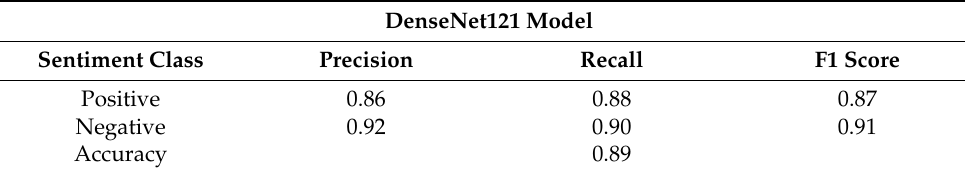
Table 6. Performance metrics of the DenseNet121 model for image sentiment classification.